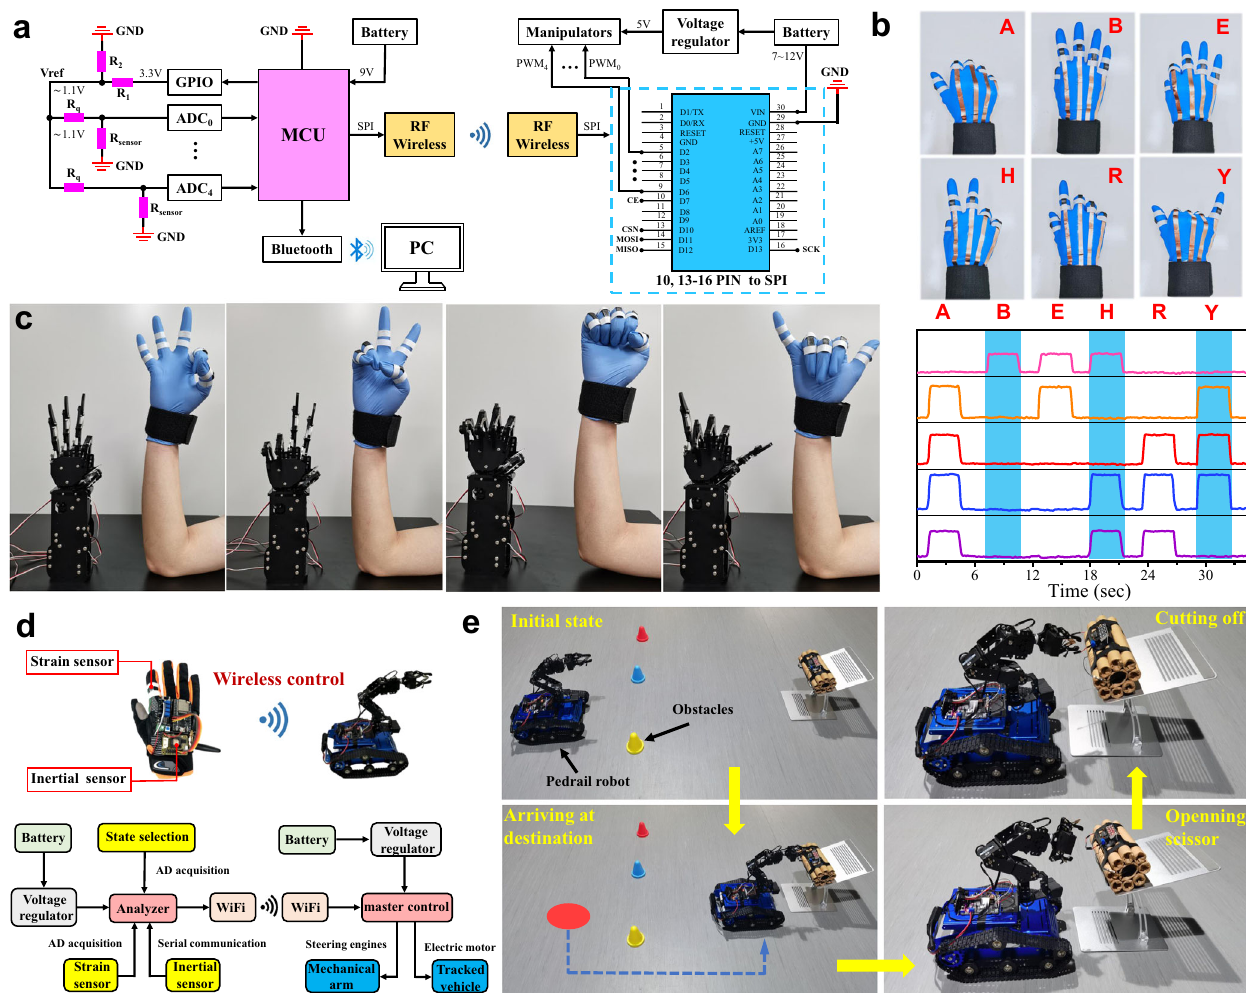
Fig. 6 Applications of graphene/Eco fl ex strain sensor in human-machine interface. a Circuit scheme showing the signal transduction, processing, and wireless transmission by using graphene/Eco fl ex strain sensors to realize gesture recognition and gesture control. b Photographs of a ‘ data glove ’ mounted with the assembled graphene/Eco fl ex strain sensors to perform a series of gestures and the relative resistance changes of each strain sensor when expressing the letters ‘ A ’ , ‘ B ’ , ‘ E ’ , ‘ H ’ ‘ R ’ and ‘ Y ’ . c Photographs of gesture control. d Schematic diagram of smart glove and pedrail robot and control process. e Photographs of the motion path of the pedrail robot and the thread trimming using medical tapes. Movements of joints and mechanical signals of skin deformation were detected using the graphene/Eco fl ex strain sensor with